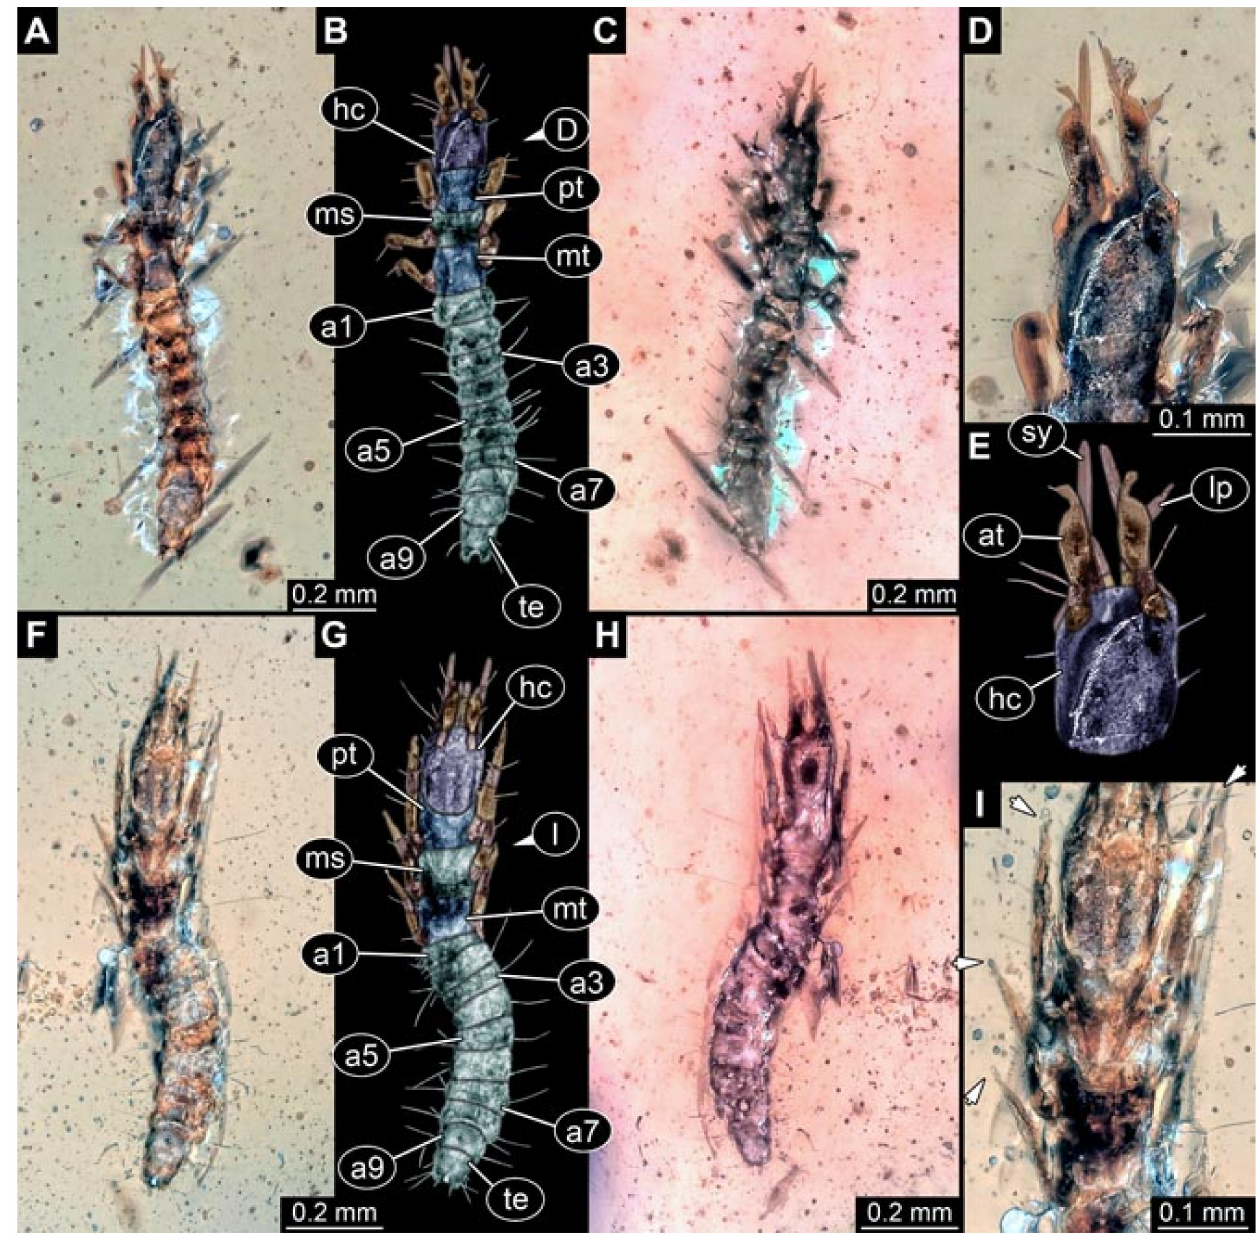
Figure 16. Specimens in Myanmar amber. ( A – E ) Specimen 5840 (PED 0900-1). ( A ) Dorsal view. ( B ) Dorsal view, colour- marked. ( C ) Ventral view. ( D ) Close-up of head in dorsal view. ( E ) Close-up of head in dorsal view, colour-marked. ( F – I ) Specimen 5841 (PED 0900-2). ( F ) Dorsal view. ( G ) Dorsal view, colour-marked. ( H ) Ventral view. ( I ) Close-up of trunk appendages with empodia (arrows). Abbreviations: a1–a9 = abdomen segment 1–9; at = antenna; hc = head capsule; lp = labial palp; ms = mesothorax; mt = metathorax; pt = prothorax; sy = stylet; te = trunk